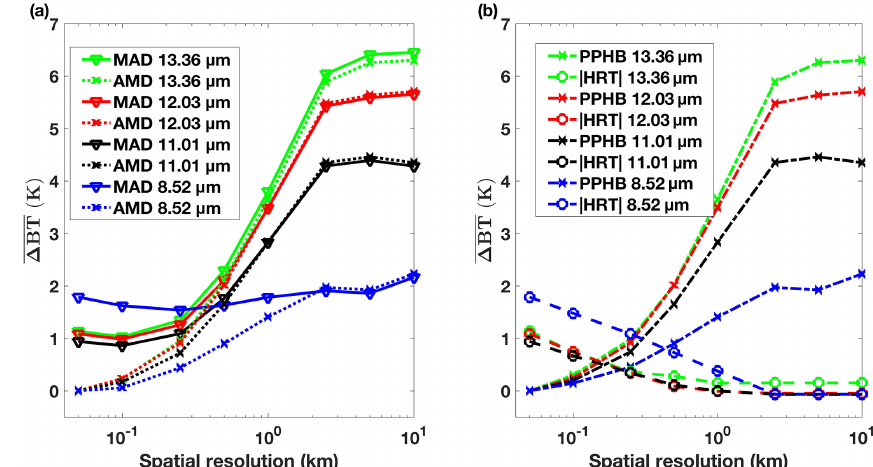
Figure 8. (a) Mean absolute difference (MAD) and arithmetic mean difference (AMD) between brightness temperatures computed in 3-D or 1-D following Eq. (2) and (b) plane-parallel and homogeneous bias (PPHB) and mean deviation due to the horizontal radiative transport ( | HRT | ) on brightness temperatures as a function of the spatial resolution for channels at 8.52, 11.01, 12.03 and 13 .